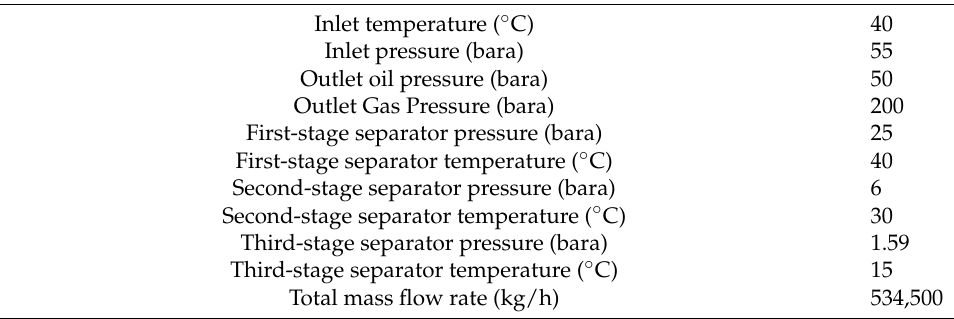
Figure 2. Process flow diagram of the topside processing system. Table 1. Key properties of the